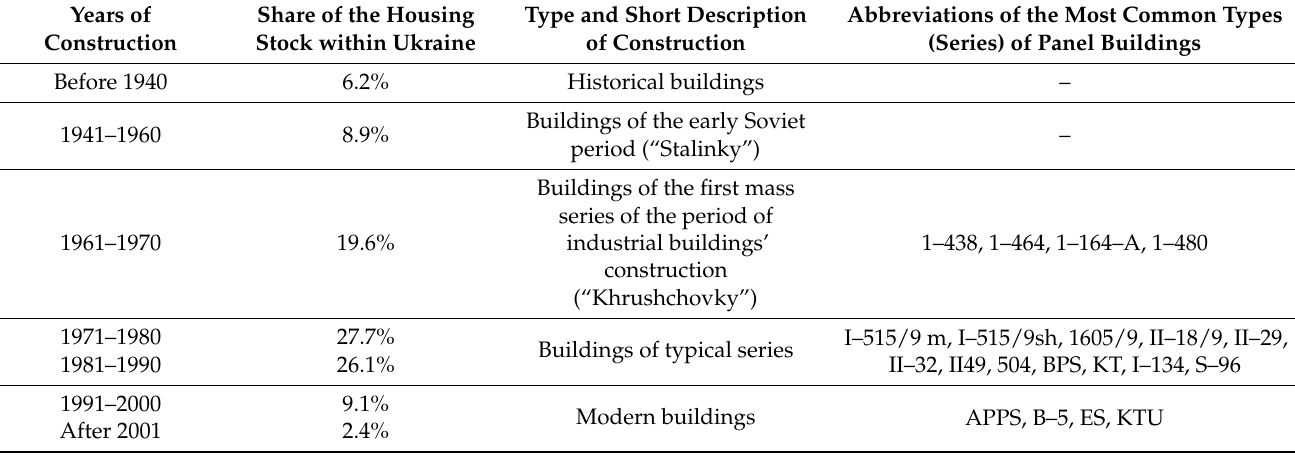
Table 1. The housing stock (apartment buildings) of Ukraine is distributed by years of